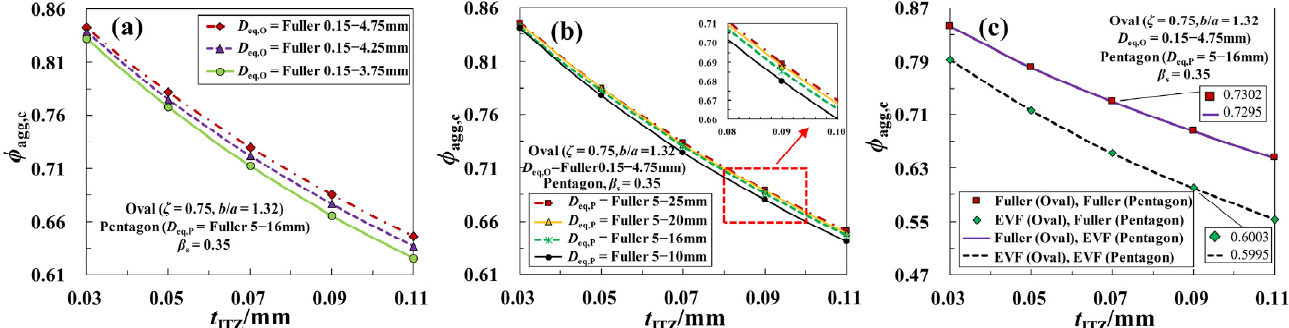
Figure 10. Effect of the size distributions of aggregate particles on the curves of ϕ agg,c - t ITZ : ( a ) Effect of the size ranges of oval fine aggregates; ( b ) Effect of the size ranges of polygonal coarse aggregates; ( c ) Effect of the size gradations of aggregates. ( c ) Effect of the size gradations of